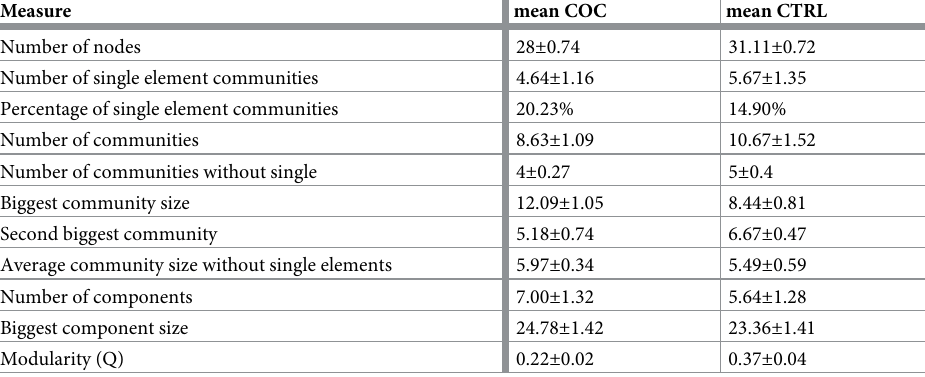
Table 2. Mid level network-based measures. Table represent values calculated on middle (community) level of net- work for control (CTRL) and coaine (COC) population, where values are calculated using duration as node weight.